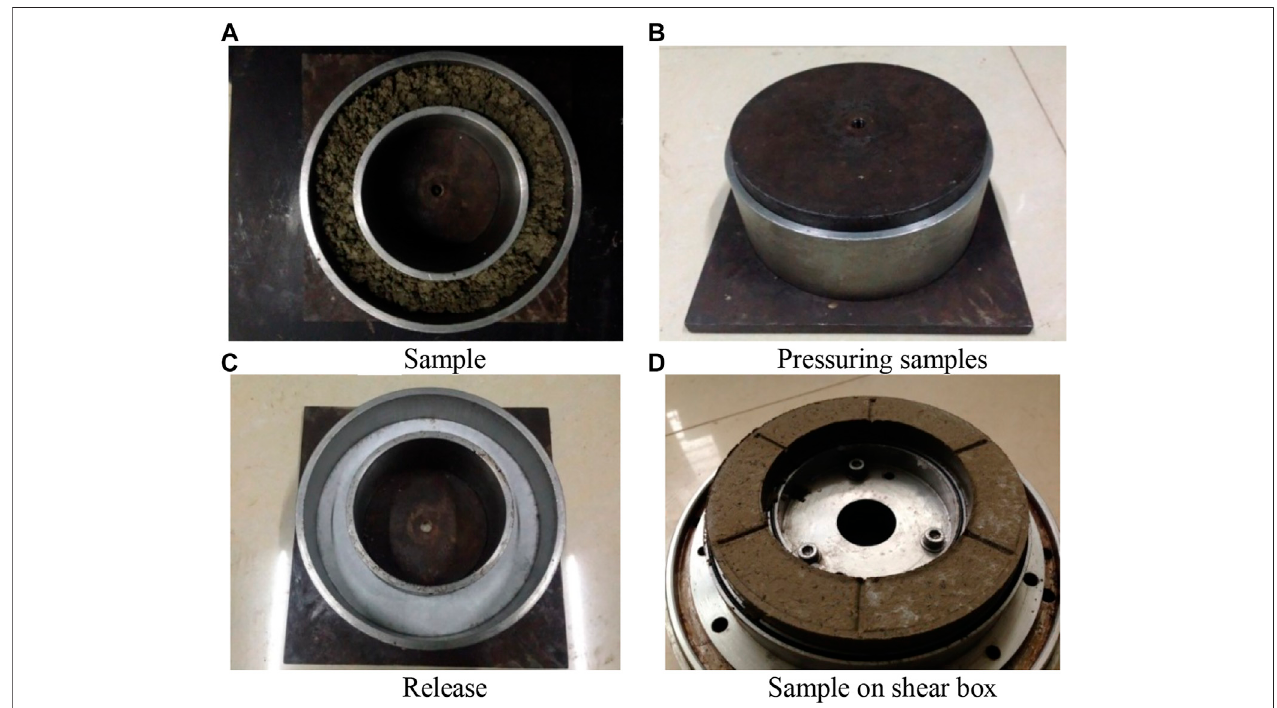
FIGURE 8 | Preparation process of remodelling ring shears. (A) Sample. (B) Pressuring samples. (C) Release. (D) Sample on the shear box.